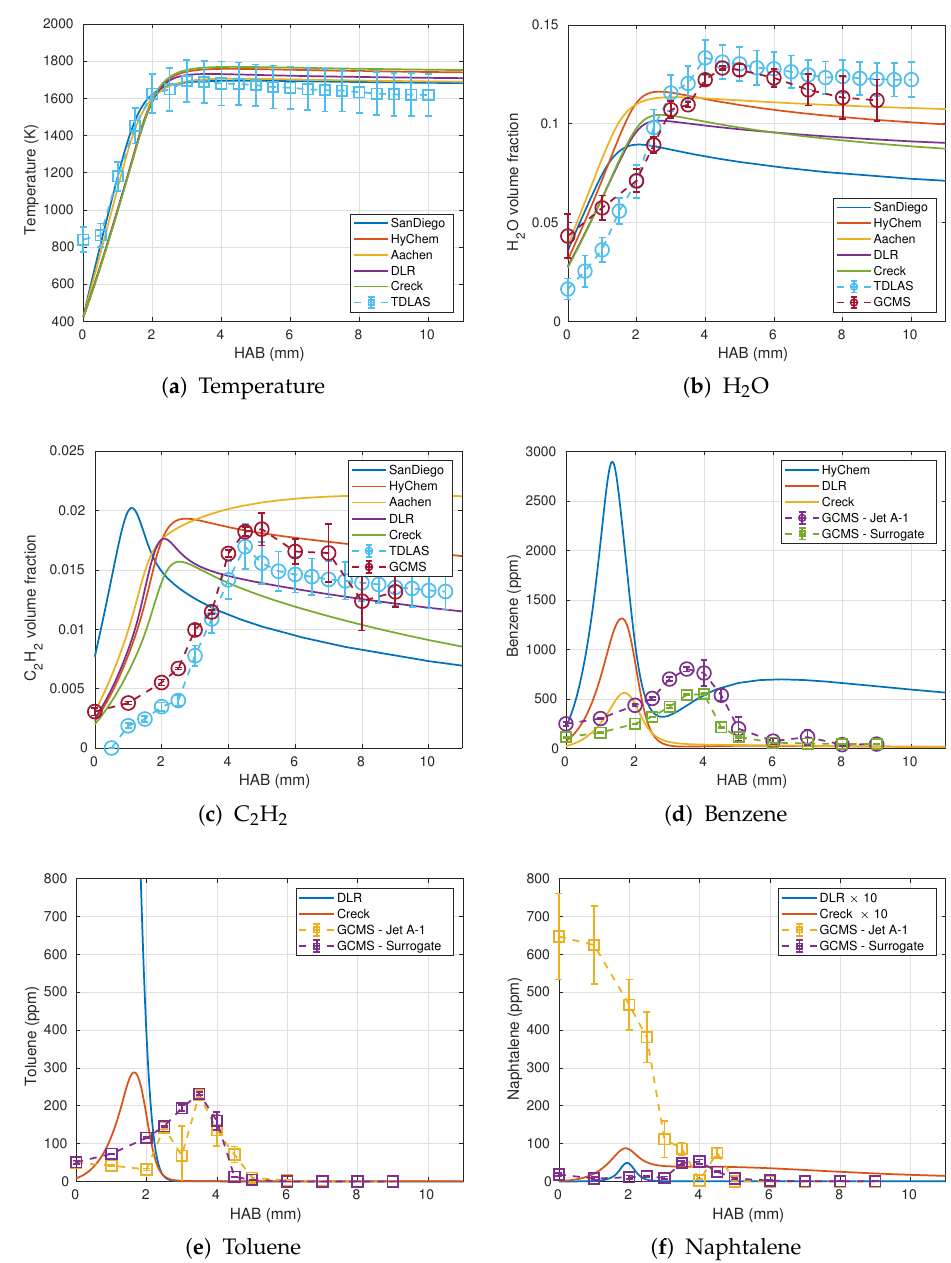
Figure 6. Comparison between measured data of Jet A-1 flame at Φ = 2.1 and v = 5 cm/s and numerical